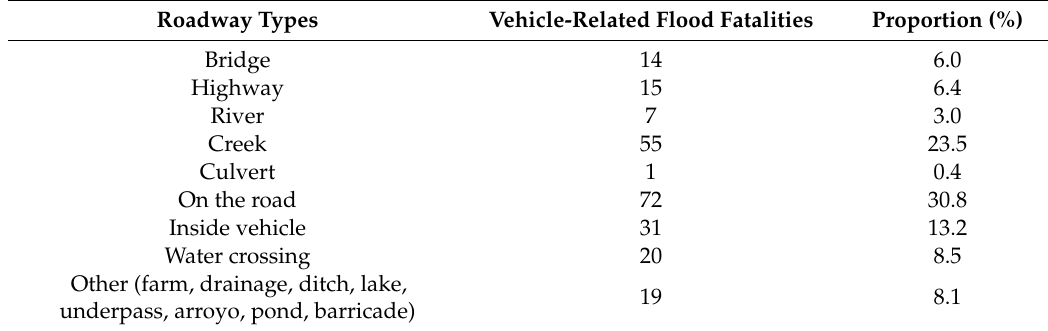
Table 3. Vehicle-related flood fatalities by roadway types in Texas,